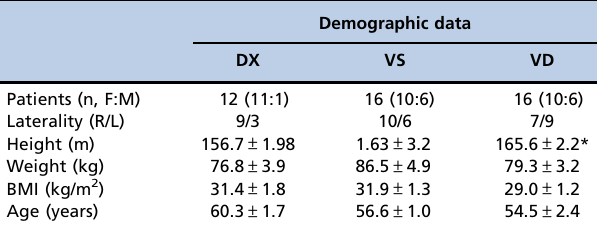
Table 1 - Demographic characteristics of patients included in the study. Demographic data of patients in each group. Demographic